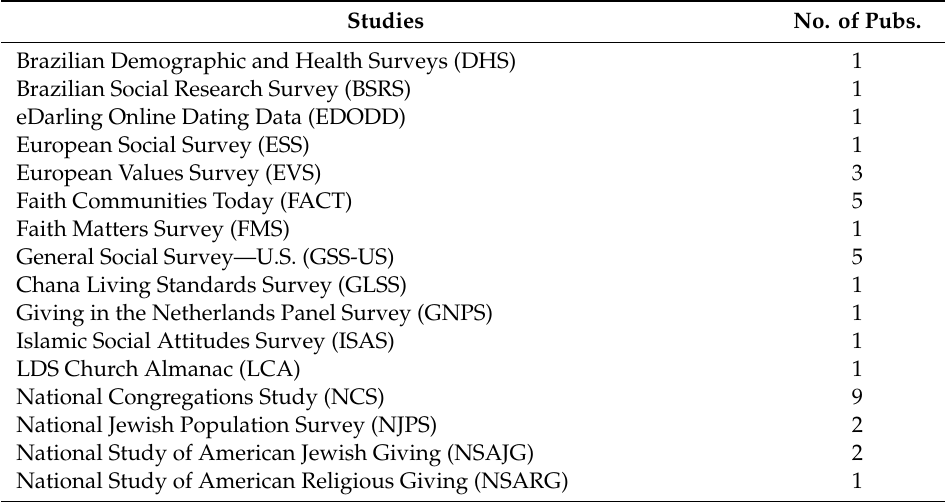
Table A2. Named studies and surveys in reviewed publications by